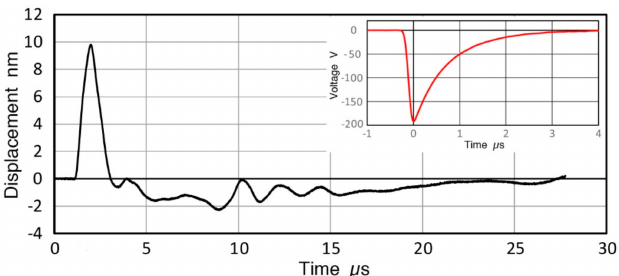
Figure 3. Pulse displacement waveform (in nm vs. µ s) of V189 transducer with input voltage pulse waveform as an insert.